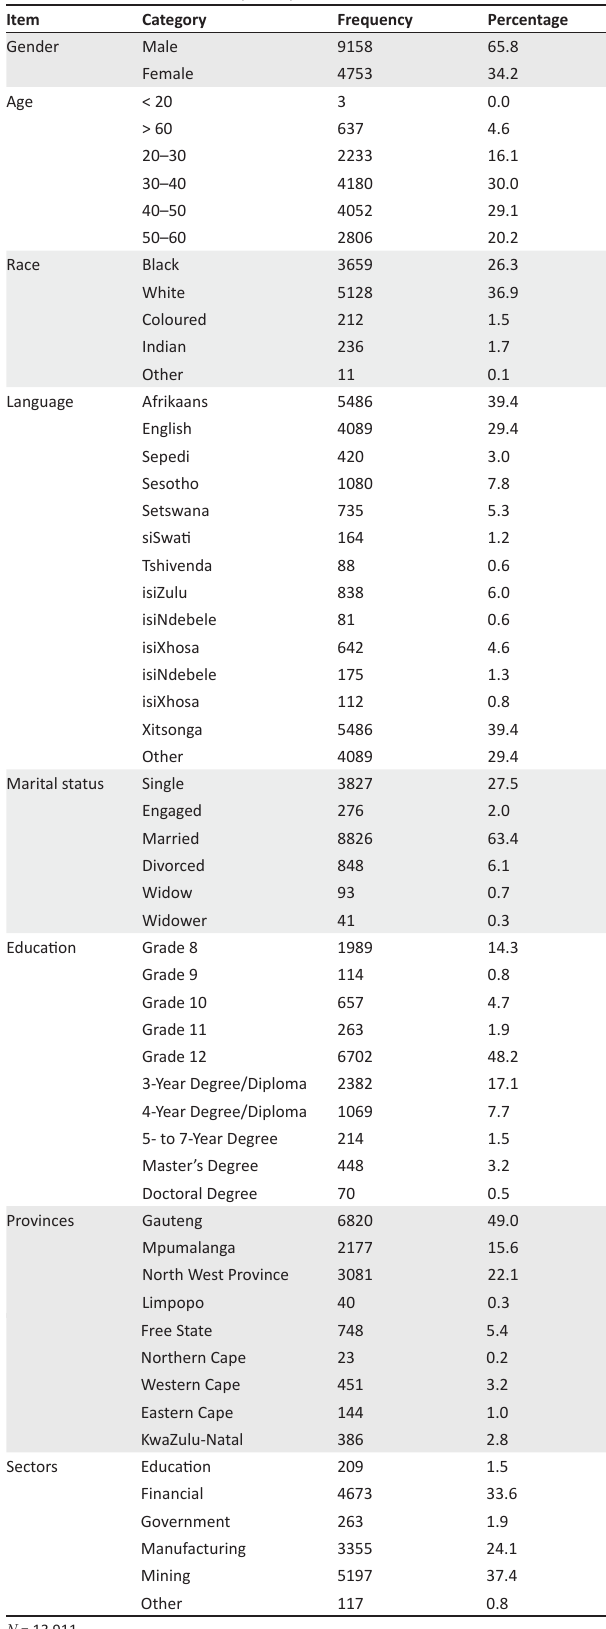
TABLE 1: Characteristics of the